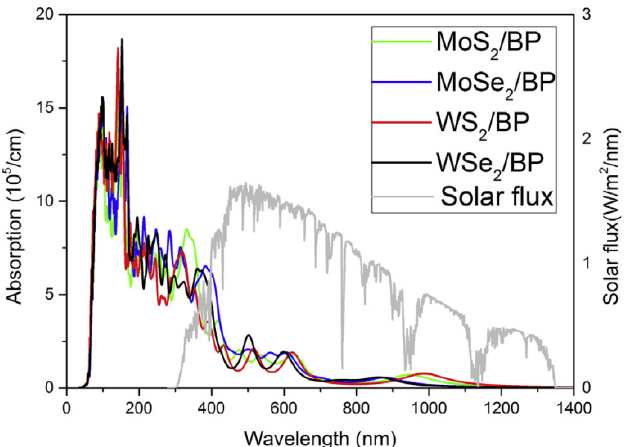
Figure 15. Optical-absorption coefficient of MoS 2 /BP, MoSe 2 /BP, WS 2 /BP, and WSe 2 /BP vdW heterostructures. (Reproduced with permission from ref. [203]. Copyright 2019 Elsevier Publications).